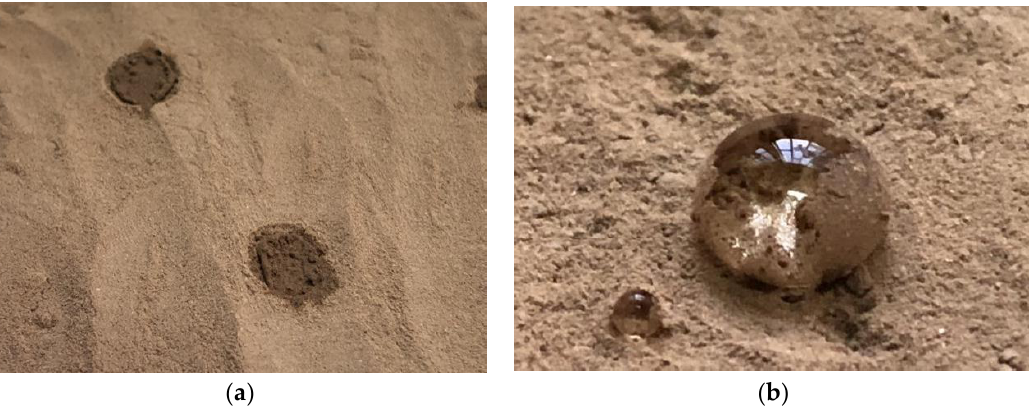
Figure 2. Water droplets on the surface of different soil samples: ( a ) Water droplets on the surface of Sample 0; ( b ) Water droplets on the surface of Sample 5.